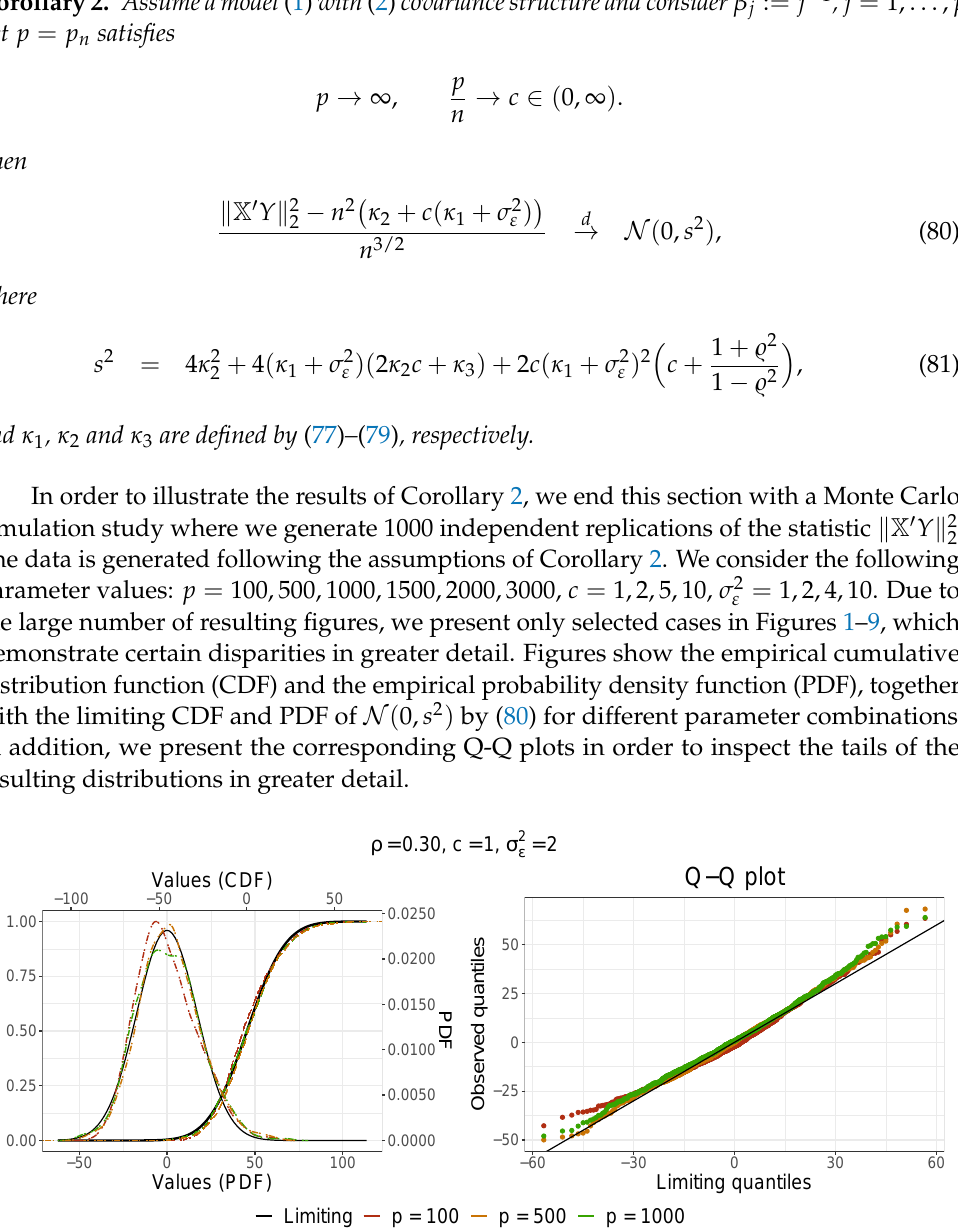
Figure 1. Comparison of the PDF and CDF ( left ) and the corresponding Q-Q plots ( right ) after 1000 replications from the Monte Carlo simulation of the statistic (80) with the limiting distribution N ( 0, s 2 ) by the Corollary 2 (in black) for (cid:36) = 0.3, c = 1, σ 2 = 2 and p = ε